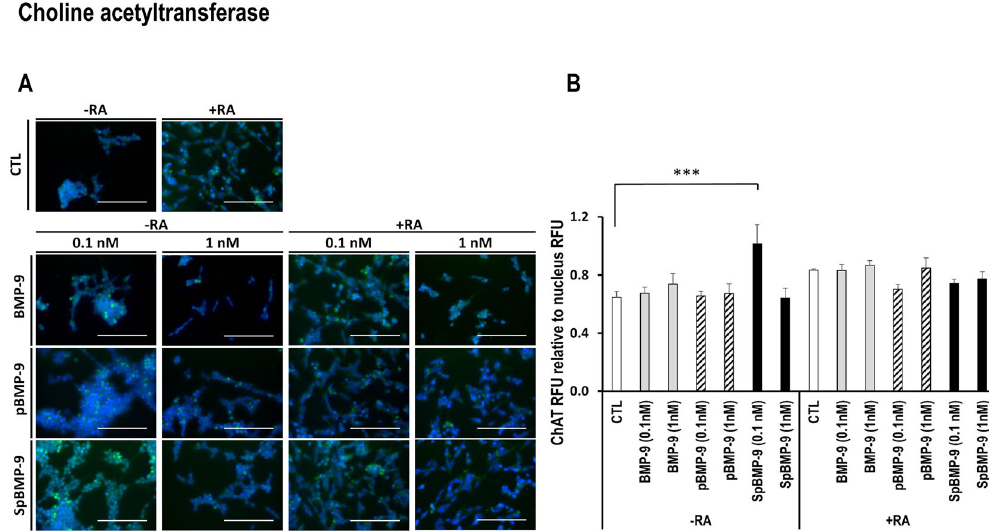
Figure 5. Effect of pBMP-9 and SpBMP-9 on the expression of choline acetyltransferase. ( A ) Merged pictures showing immunostaining for ChAT (FITC, green) and nuclei labelling (Hoechst, blue) of SH-SY5Y cells stimulated for 5d with 0, 0.1, or 1 nM BMP-9, pBMP-9 and SpBMP-9 + / − 10 μ M RA (Bar = 100 μ m). Pictures are representative of at least 2 independent experiments. ( B ) Analysis of ChAT fluorescence intensity relative to the nucleus staining was also presented. Results are the means ± SEM ( *** p < 0.001).